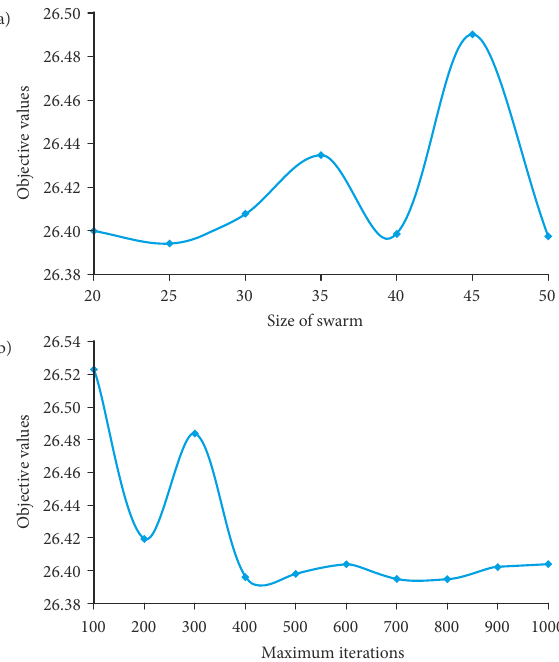
Figure 2. Results of sensitivity analysis tests: (a) swarm size;